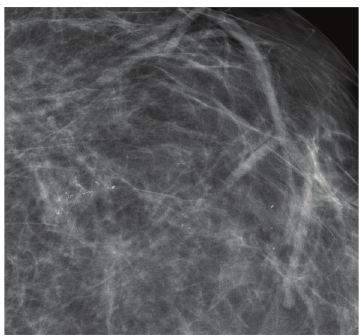
Figure 3: Left magnified craniocaudal image shows branching pleo- morphic